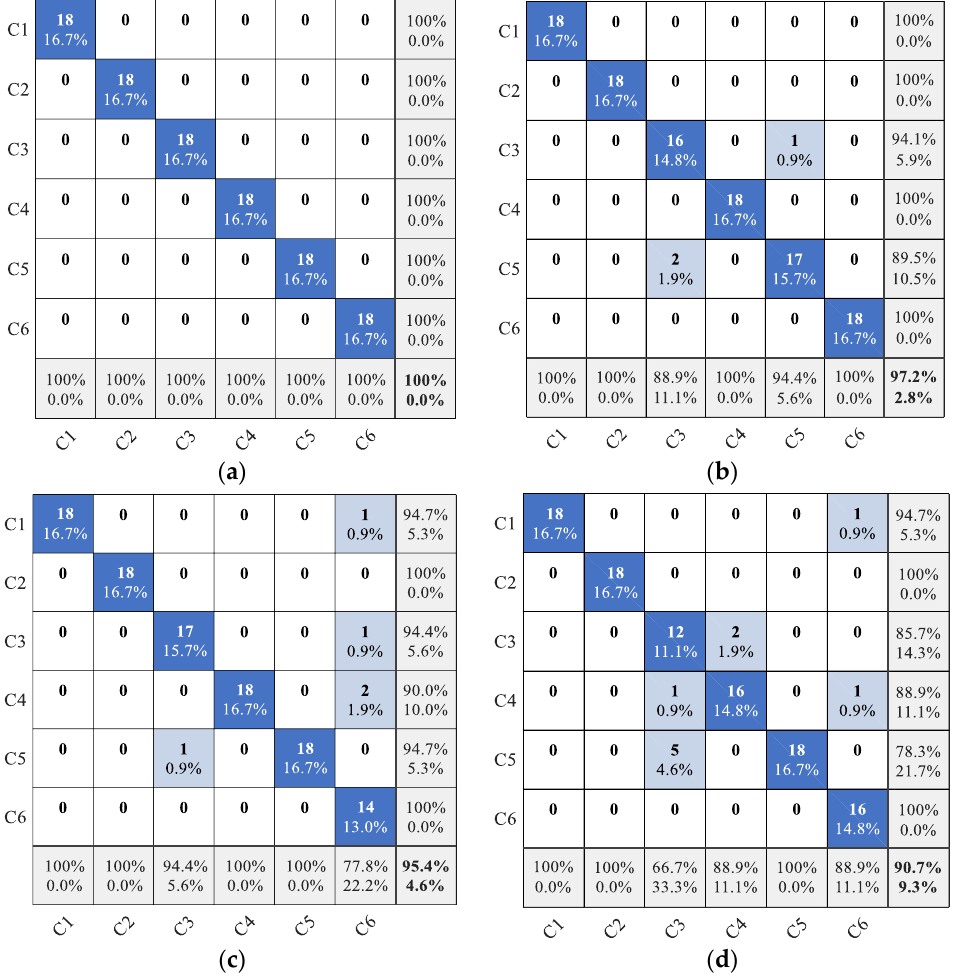
Table 3. Comparison of classification accuracy of four